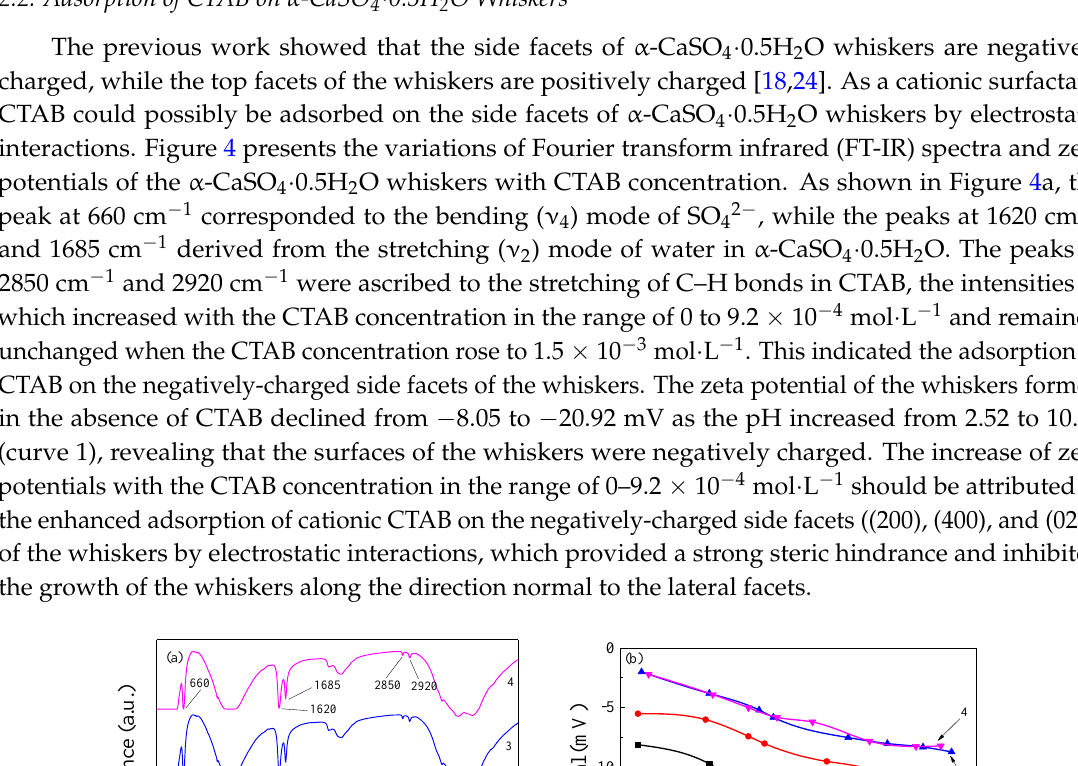
· L − 1 ): 1—0, 2—1.0 × 10 − 4 , 3—9.2 × 10 − 4 ,